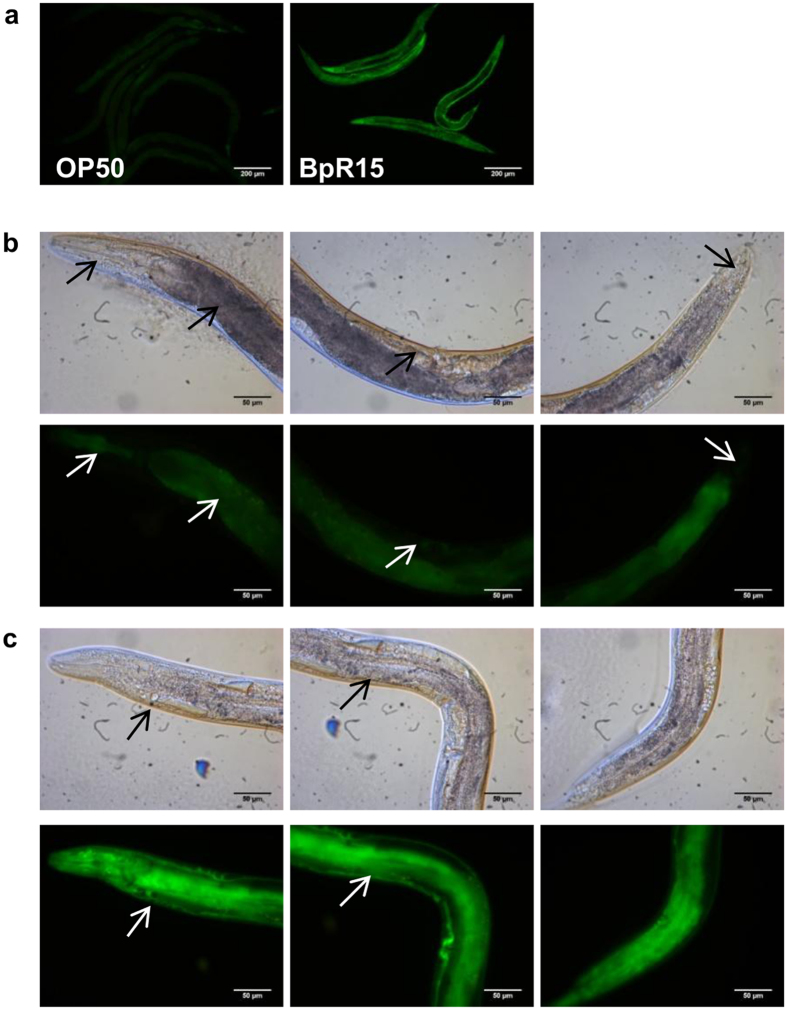
ugt-29 is expressed ubiquitously in worms upon B. pseudomallei infection.(a) Representative fluorescence micrographs (100× magnification) of GFP expression indicating the endogenous transcriptional activity of ugt–29 in worms fed with E. coli OP50 and BpR15 at 24 hours post infection. Representative micrographs (400× magnification) showing the basal expression of ugt-29 in (b) E. coli OP50-fed worms and the elevated expression of GFP in (c) the worms infected by BpR15 at 8 hours post infection. For (b,c), micrographs in the upper panel are DIC images whilst the lower panel displays the fluorescence micrographs. Constitutive but dim expression of GFP was noted specifically at the pharynx, intestine, vulva muscle and tail (the body parts are denoted by arrows from left to right) of E. coli OP50-fed worms. Fluorescence micrographs of the same magnification were acquired at same exposure time and gain factor. Scale bars, 200 μm (100×) and 50 μm (400×).